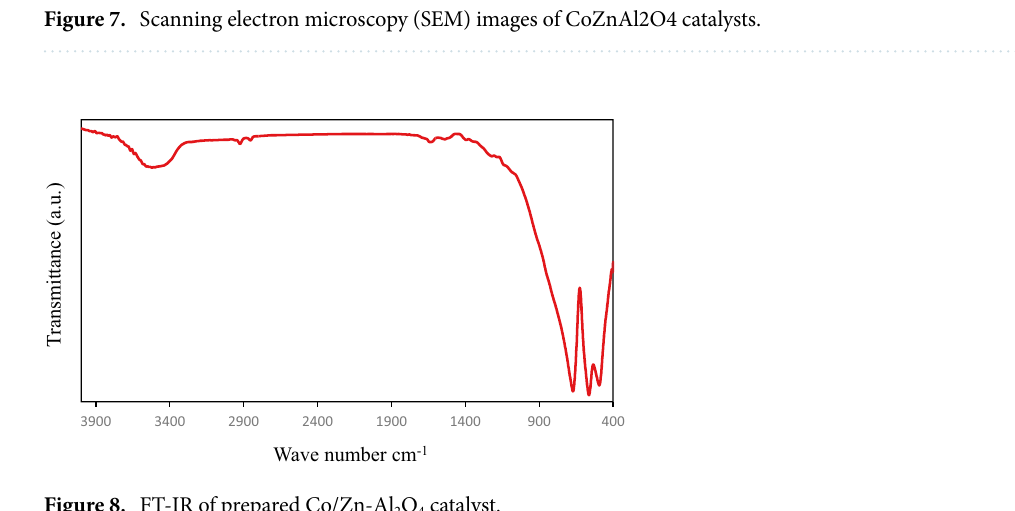
Figure 8. FT-IR of prepared Co/Zn-Al 2 O 4 catalyst.